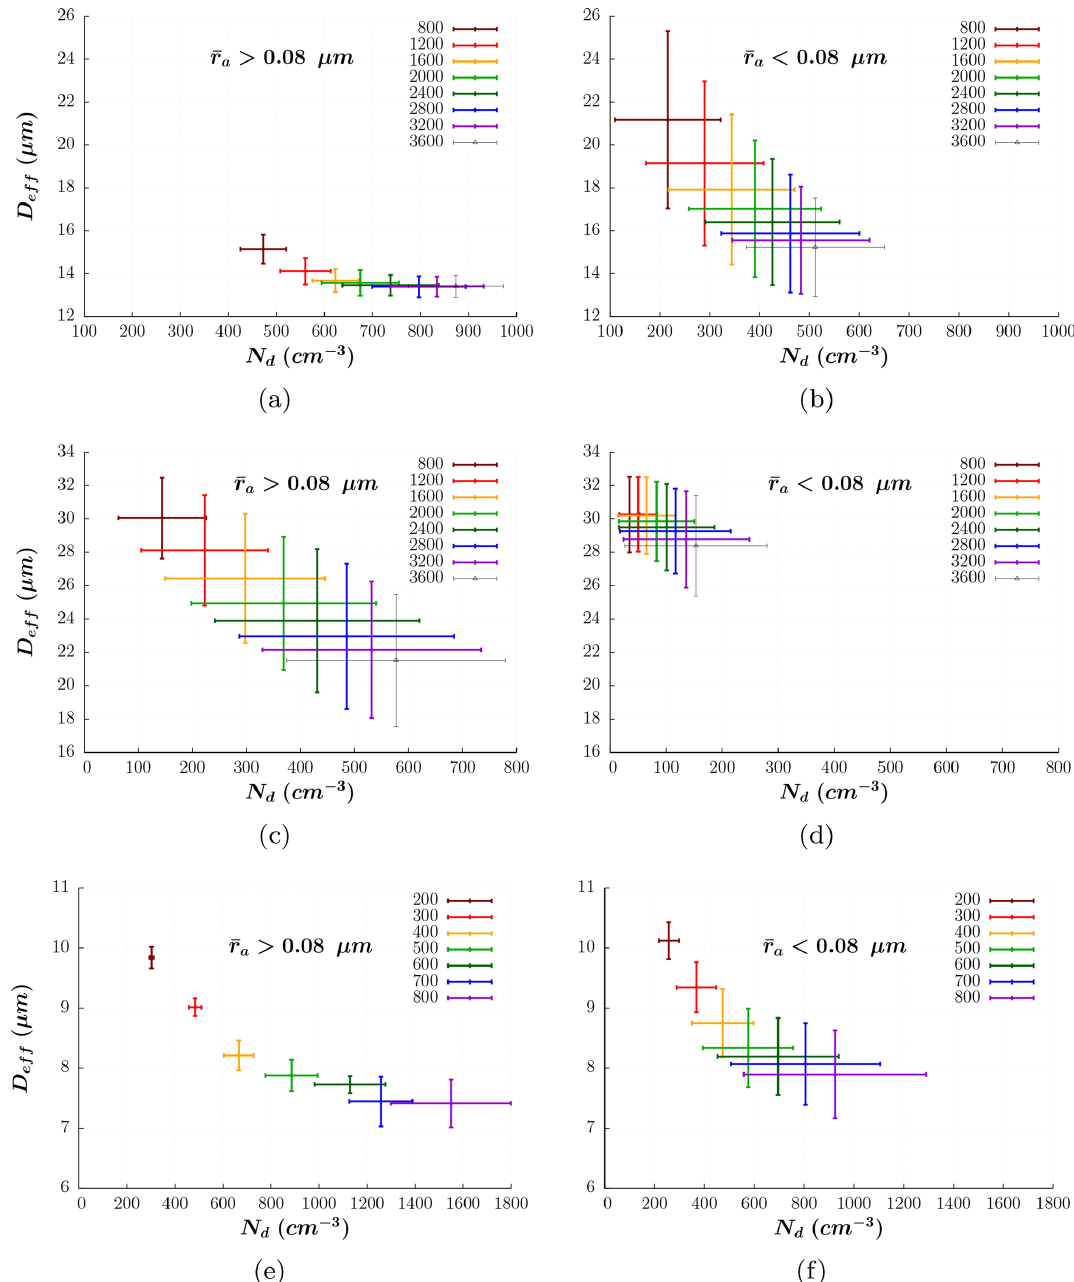
Figure 10. Mean and standard deviation of N d and D eff at cloud top from the simulations with entrainment and bins for the aerosols (a, b) , without entrainment (c, d) and without bins for the aerosol (e, f)